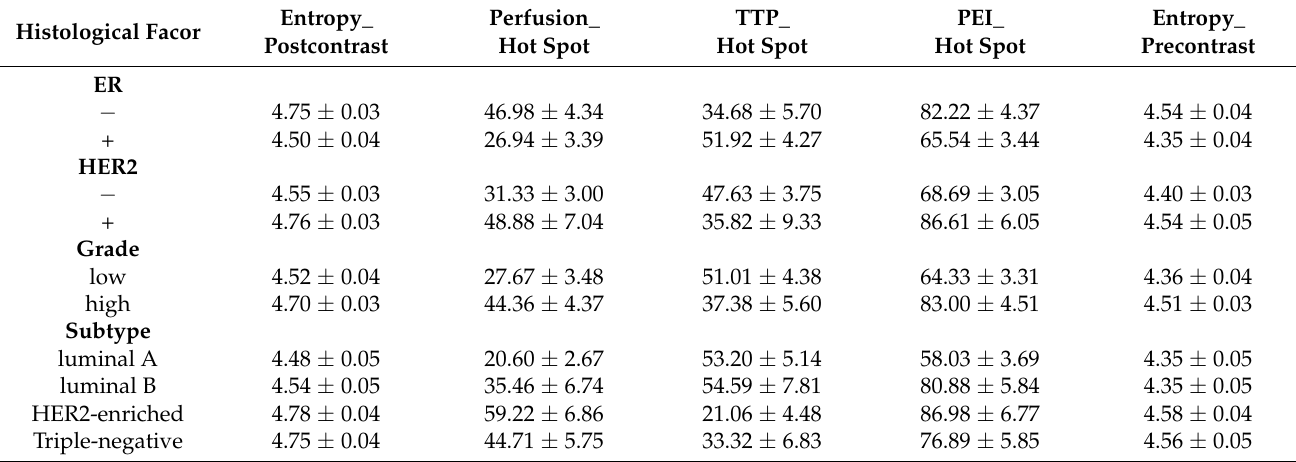
Table 7. Values of the top five important CT parameters according to histological factors in the training